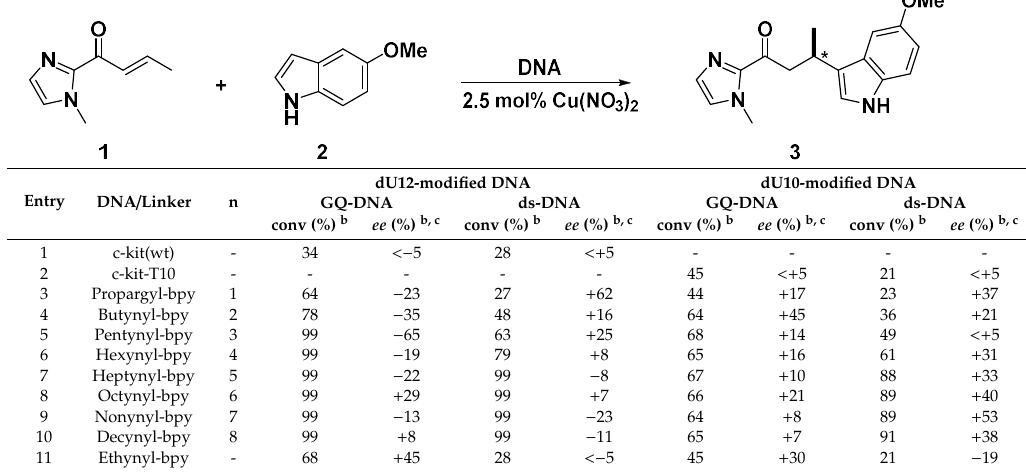
Table 1. Results of the Friedel – Crafts alkylation reaction catalyzed by dU12/dU10-modified c-kit DNA and Cu(II). a